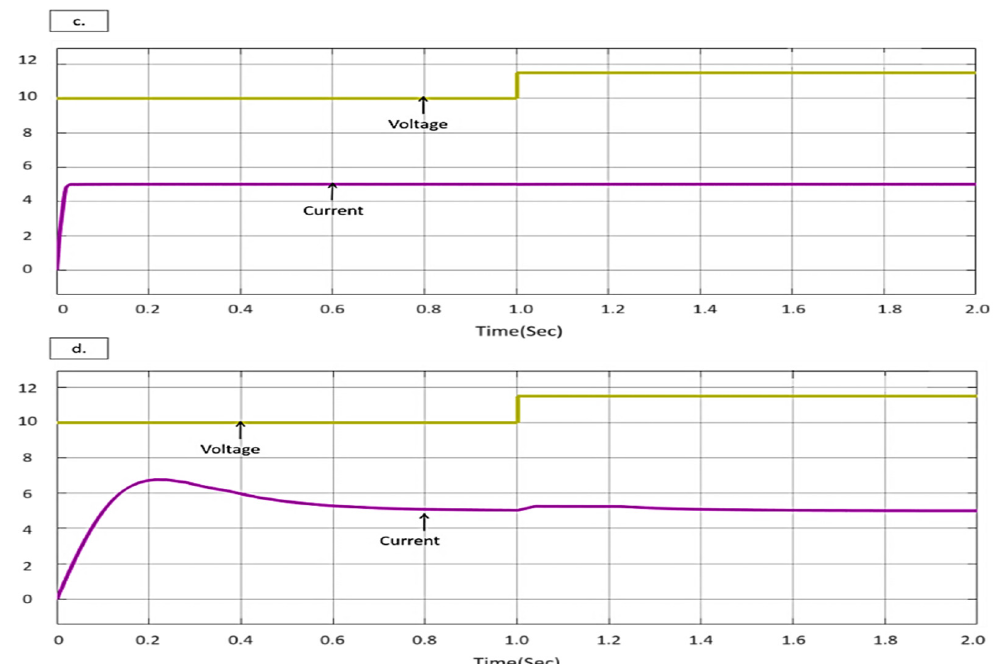
Figure 14. Simulation results during input voltage step-up (100 V to 115 V voltage scaling 1 box = 20 V):